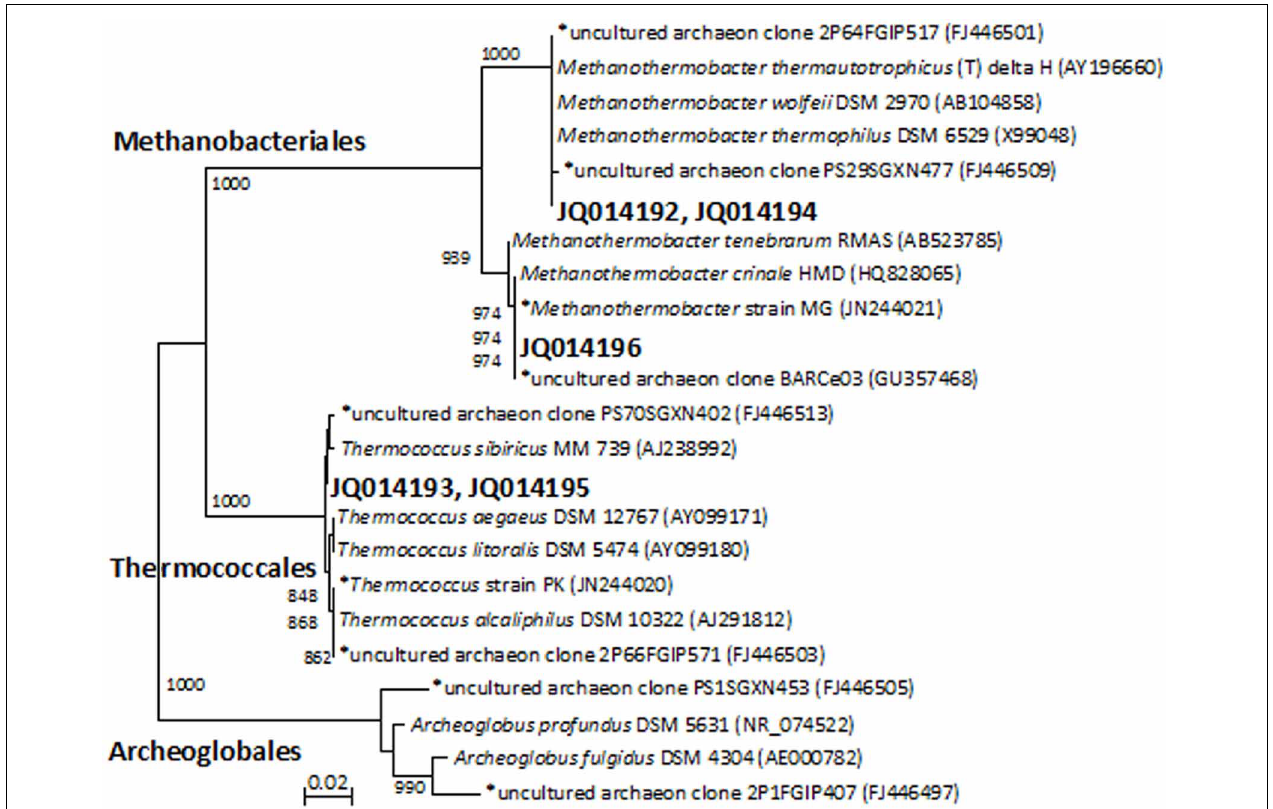
FIGURE 1 | Phylogenetic relationships of archaeal 16S rRNA gene sequences obtained from the excised DGGE bands from enrichments and MPN cultures. The tree is constructed from approximately 350 bp 16S rRNA gene sequences using the neighbor-joining algorithm. One thousand bootstrap replications were performed; only values greater than 700 are